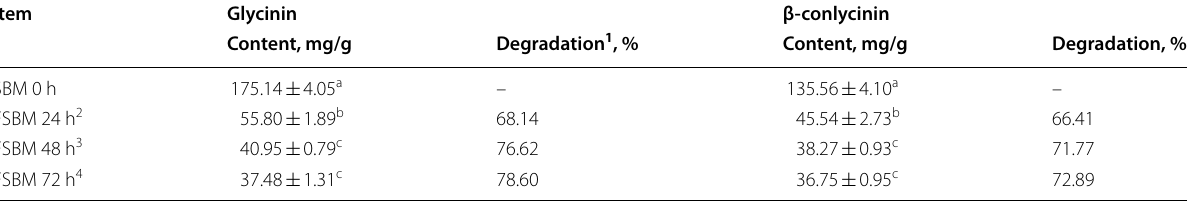
Values are means of three replicates per treatment. Means in a row without common superscript differ significantly (P < 0.05) 1 Degradation rate (soybean antigenic protein content in uninoculated SBM = uninoculated SBM 100% × 2 FSBM 24 h: the soybean meal was inoculated with B. velezensis 157 and fermented at 37 °C for 24 h 3 FSBM 48 h: the first-stage fermentation was inoculated with B. velezensis 157, incubated at 37 °C for 24 h, then were inoculated with L. plantarum BLCC2-0015 and fermented under anaerobic conditions at 37 °C for another 24 h, totally 48